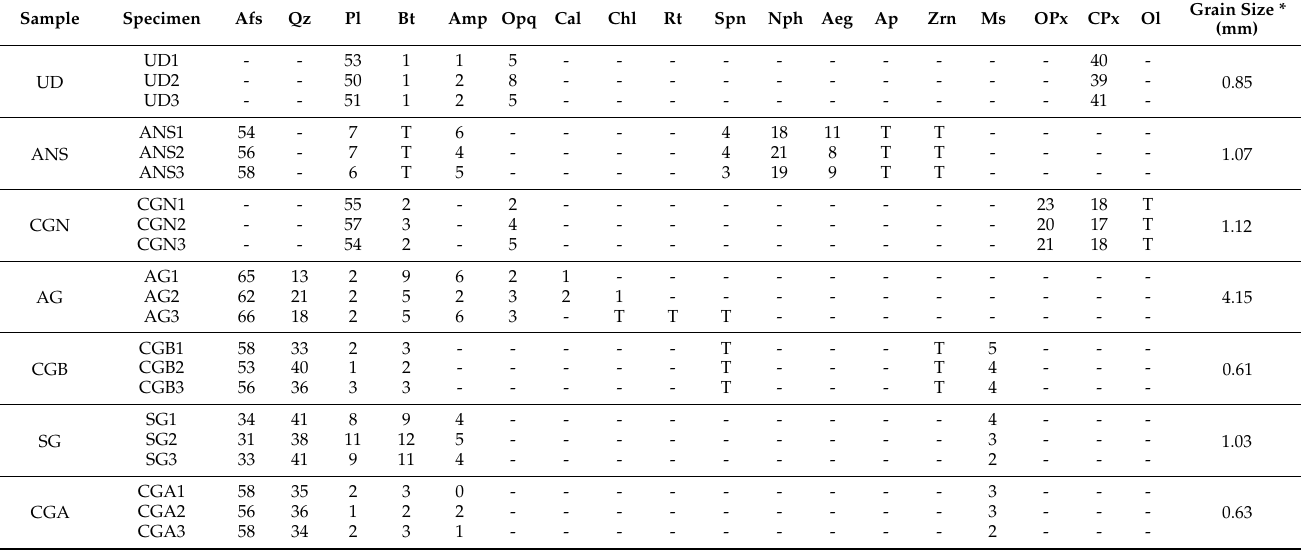
Table 2. Modal mineralogy of the studied rocks.